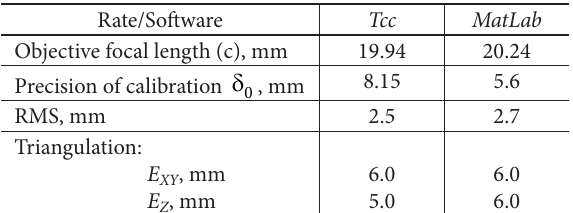
Table 4. Calibration accuracy of the